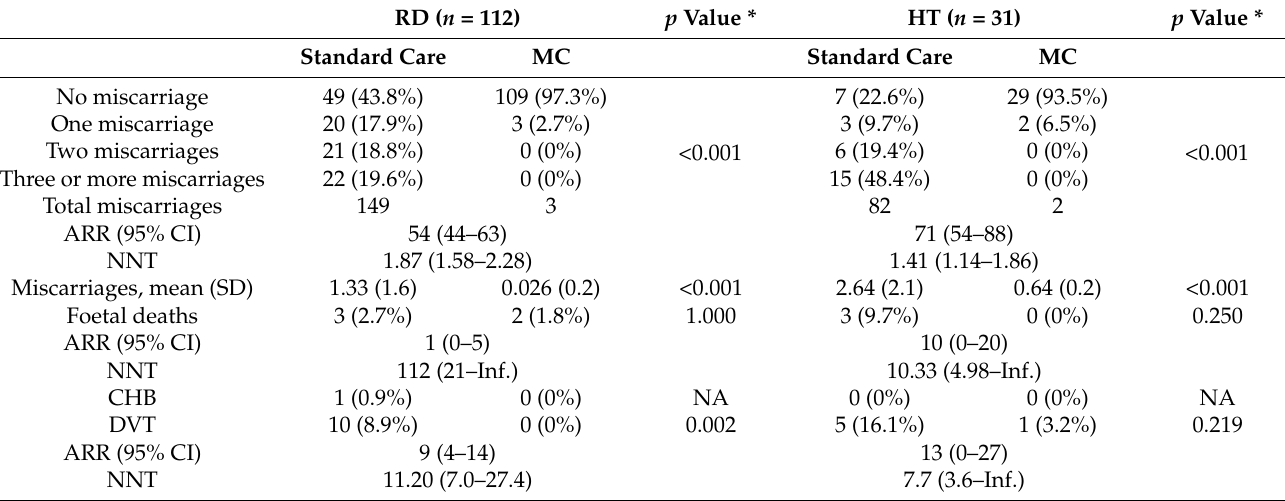
Table 3. Comparison of ANOs, thrombotic episodes, and CHB in 143 pregnant women treated in standard care and when treated at an